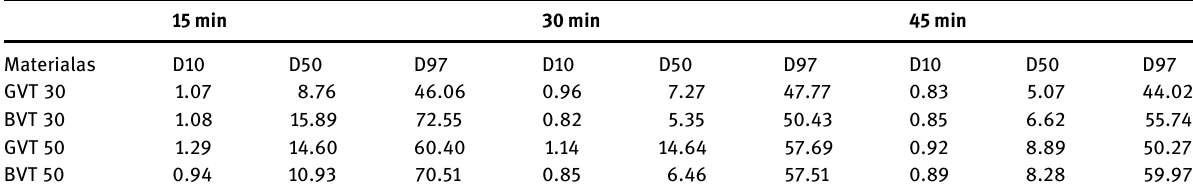
Table 2: Grinding time particle size relationship